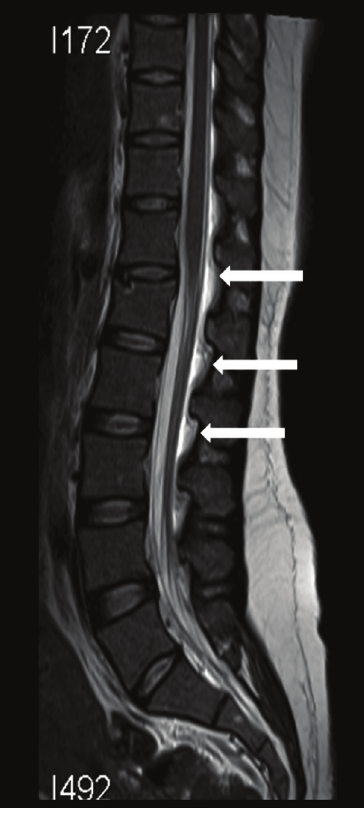
Figure 3. MR imaging of the spine. T2W sequence shows rim epidural CSF collection in the posterior aspect D11–L3 vertebra suggestive of CSF leak (white solid